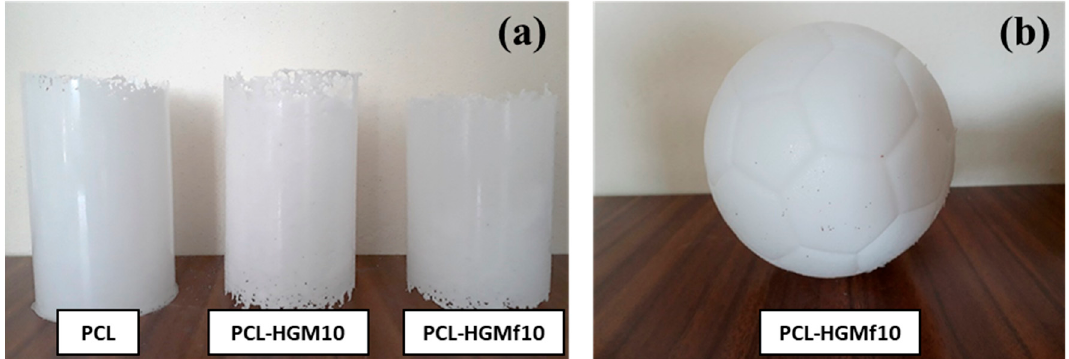
Figure 10. Rotomolding prototypes produced using lab equipment ( a ) and industrial machine ( b